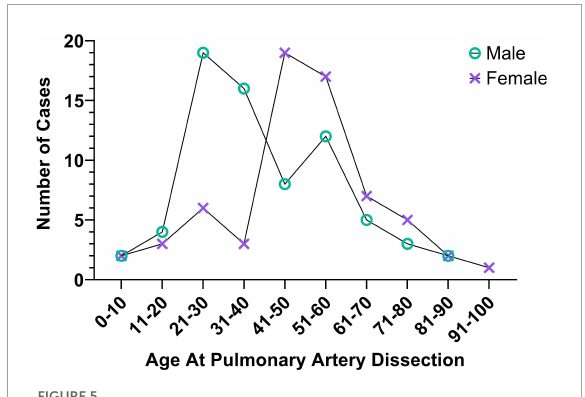
FIGURE5 Risk profiles of pulmonary artery dissection patients. Like sufferers of aortic dissections, SCAD, and CeAD, pulmonary artery dissection occurrence varies with age and sex; data from